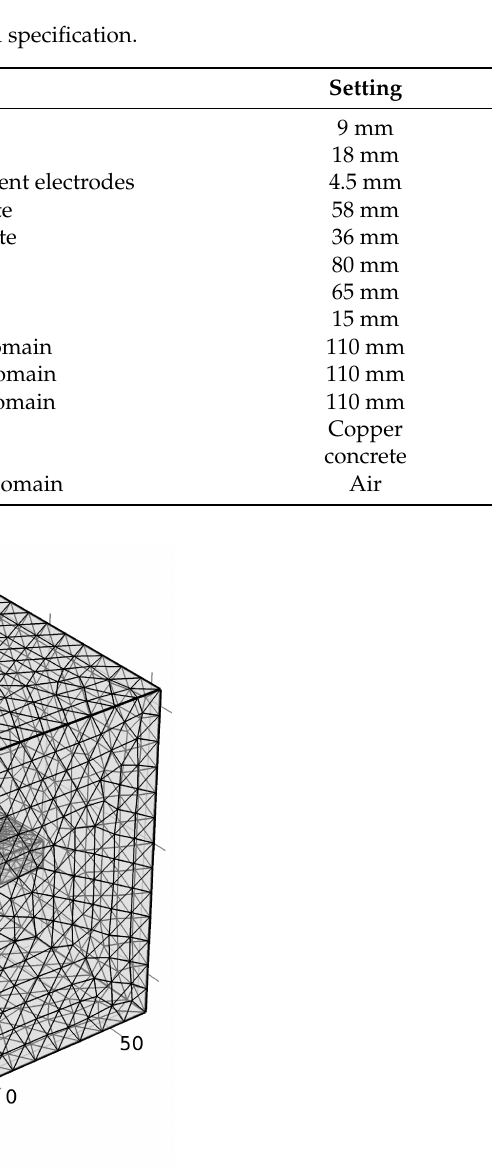
Figure 2. The model after finite element mesh generation and the mesh used to discretise the